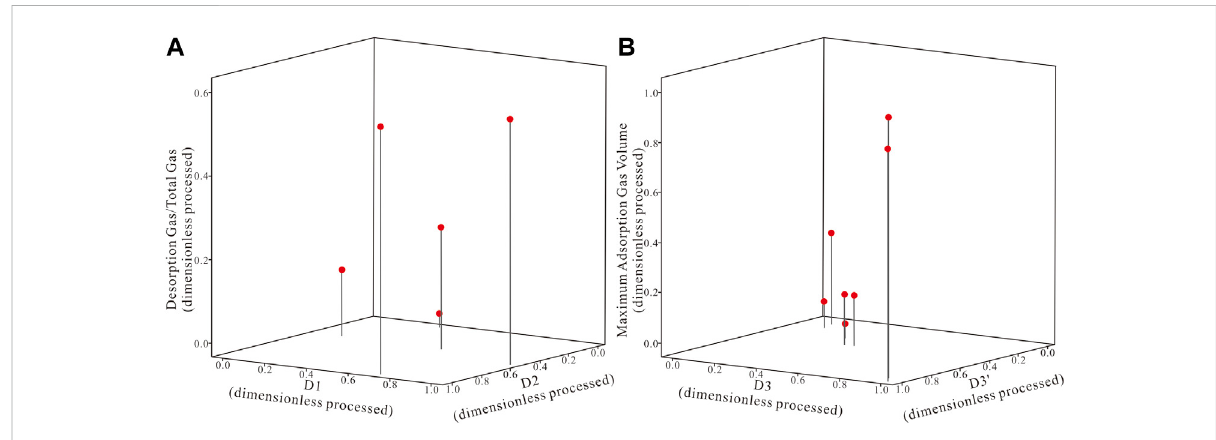
FIGURE 16 The correlation between gas content and fractal dimensions. [ (A) the correlation of desorption gas/total gas – D1 – D2; (B) the correlation of maximum adsorption gas volume – D3 – D3 ′